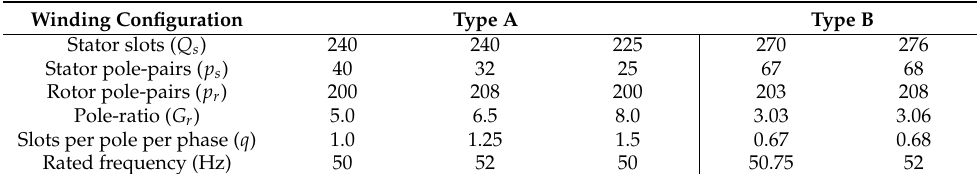
Table 4. Investigated slot/pole combinations for 3MW